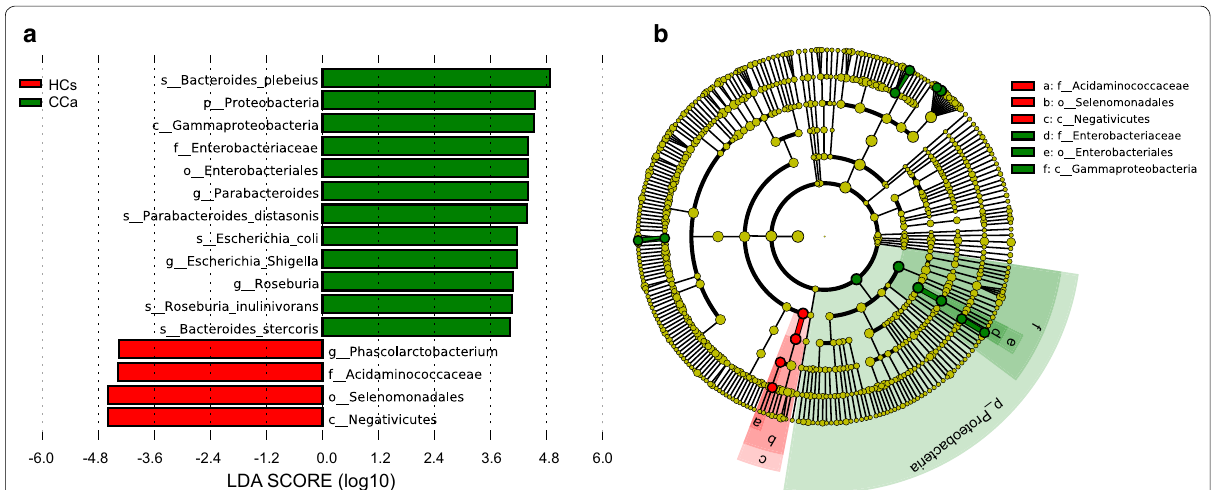
Fig. 5 Taxonomic differences were detected between cervical cancer and healthy controls. a Linear discriminative analysis (LDA) effect size (LEfSe) analysis between healthy controls (HCs, red ) and patients (CCa, green ). b Cladogram showing differentially abundant taxonomic clades with an LDA score > 4.0 among patients and